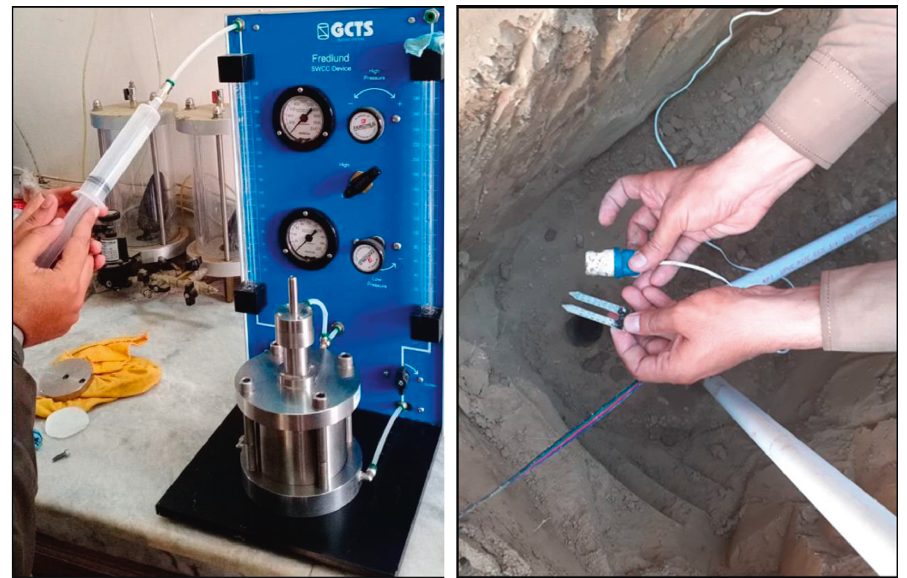
Figure 2: Demonstration of the lab- and field-testing for developing SWCCs of expansive soils. Table 1: The summary of the selected parameters for the inves- tigated soils [31].